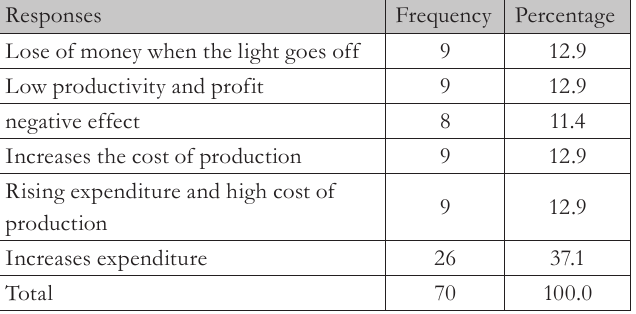
Tab. 6 - Effects of power fluctuation on expenditure. Source: Field data (2014).